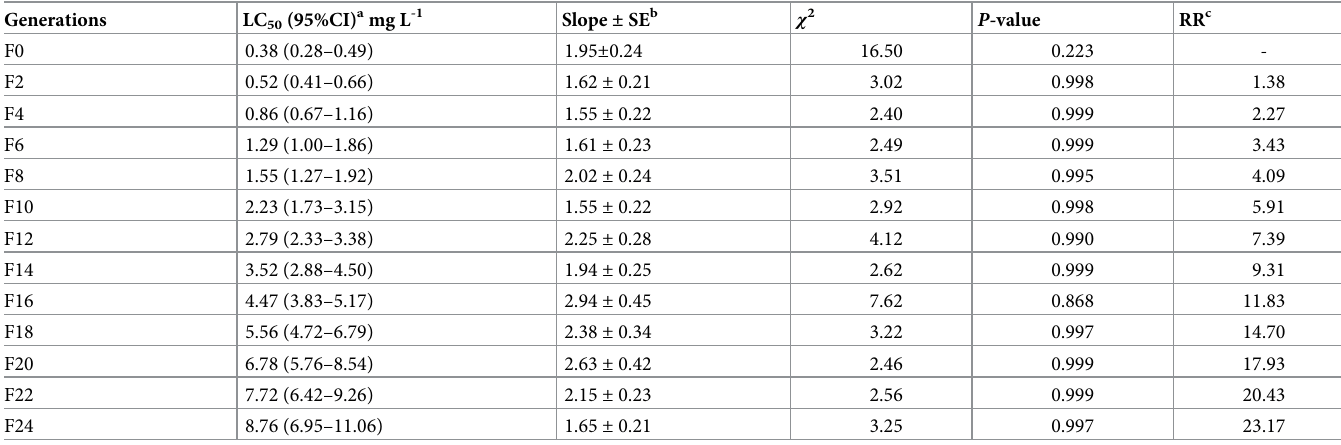
Table 1. The resistance level of Aphis gossypii to clothianidin.